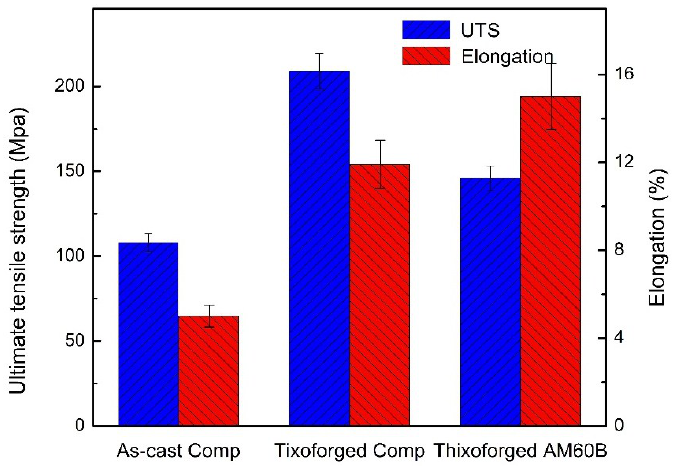
Figure 3. Tensile properties of the materials at room temperature. UTS, ultimate tensile